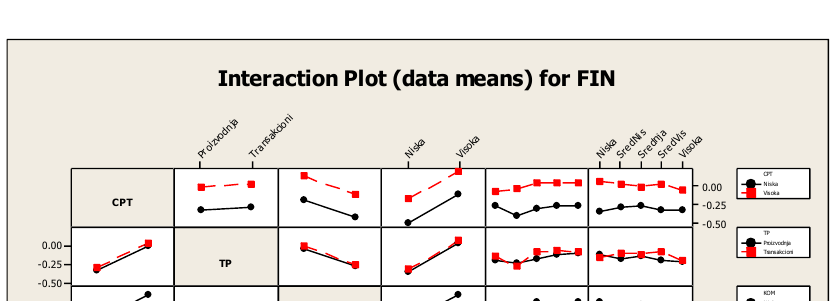
Fig. 9. FIN main effect plot